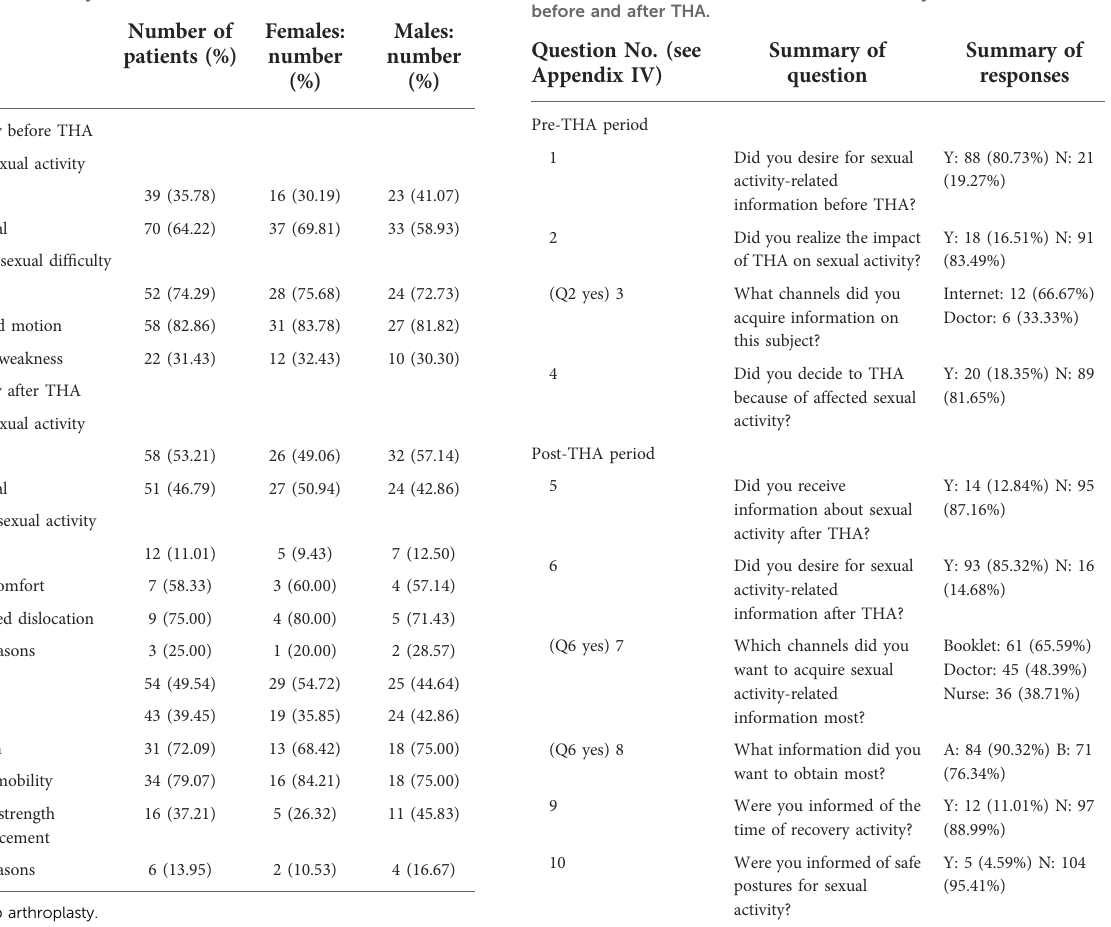
TABLE 3 Sexual activity before and after THA. TABLE 4 Patient ’ s attitude to sexual activity-related information